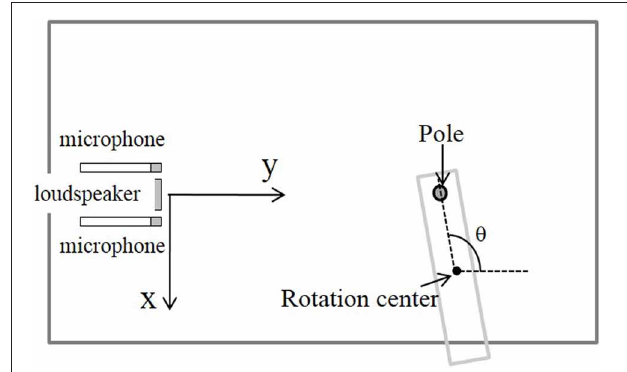
FIGURE 1 | Measuring system (top view) with a pole set on a rotating table.